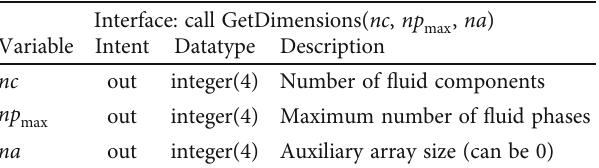
Table 2: API for GetDimensions